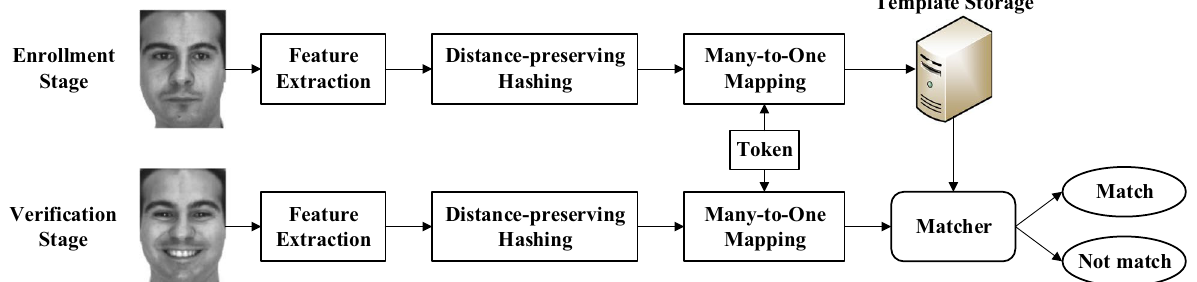
Fig. 1 An overview of our BTP